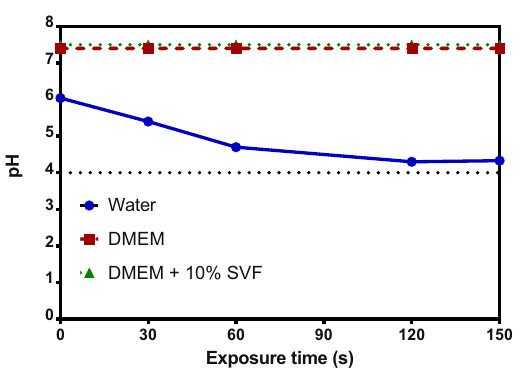
Figure 9. Variation of pH in water after He plasma treatment at various exposure